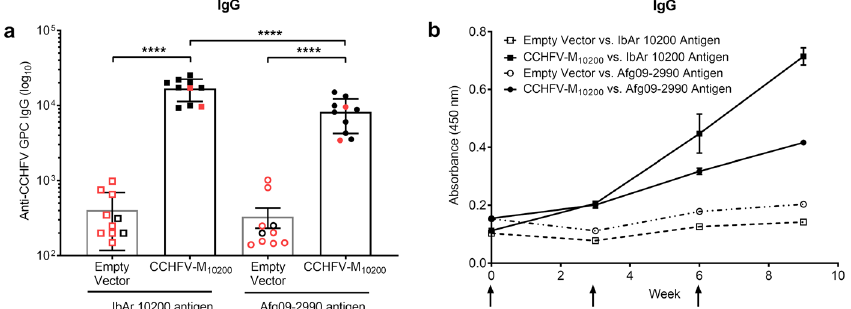
Fig. 5 CCHFV-M 10200 DNA vaccination elicits antibodies that are partially cross-reactive to CCHFV-Afg09-2990. Groups of 10 female C57BL/6 mice were vaccinated with 50 μ g CCHFV-M 10200 or empty vector on days 0, 21, and 42 by IM-EP. a Sera antibody responses were analyzed 21 days post third vaccination for anti-CCHFV-IbAr 10200 or anti-CCHFV-Afg09-2990 endpoint titers by ELISA. Mice that succumbed to viral challenge are shown in red. b Temporal anti-CCHFV IgG responses in vaccinated mice. The arrows indicate DNA vaccination time points. Data are the group mean averages ± SD. **** p < 0.0001. p values were determined by one-way ANOVA with Tukey ’ s post hoc test with a 95% con fi dence